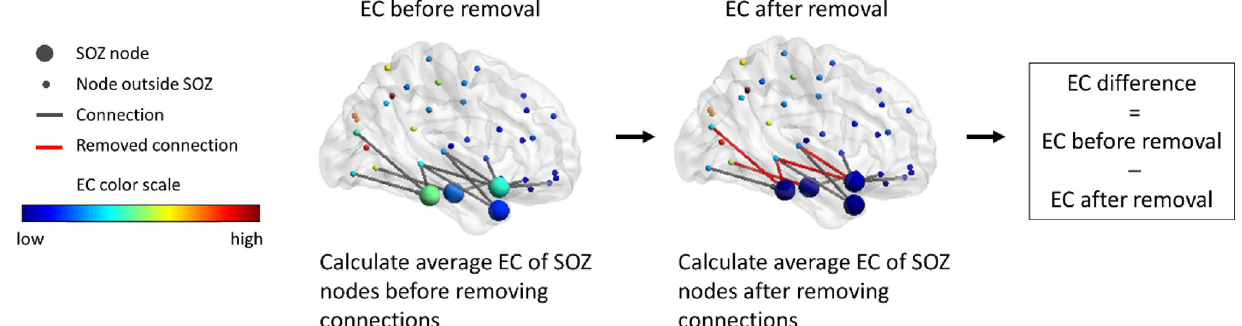
Figure 1. Illustration of the EC difference of the SOZ. The EC of each node is based on the full network (nodes inside and outside the SOZ). First, the EC is averaged over the nodes in the SOZ. After removing connections, the EC per node is re-calculated based on the resected network. Subsequently, the EC is averaged over the SOZ nodes again. The difference in EC of the SOZ nodes is the EC before removal minus the EC after removal. Parts of the figure were visualized with the BrainNet Viewer toolbox (Xia et al. 2013) (http:// www. nitrc. org/ proje cts/ the algorithm minimized the negative value of the EC difference (object function = − EC difference). Simulated annealing optimized the combination of a fixed number of candidate connections (i.e. for a fixed resection size), after it was given an initial guess containing a random selection among all candidate connections. The algorithm considered neighboring states that were generated from the previous state, in our case by changing